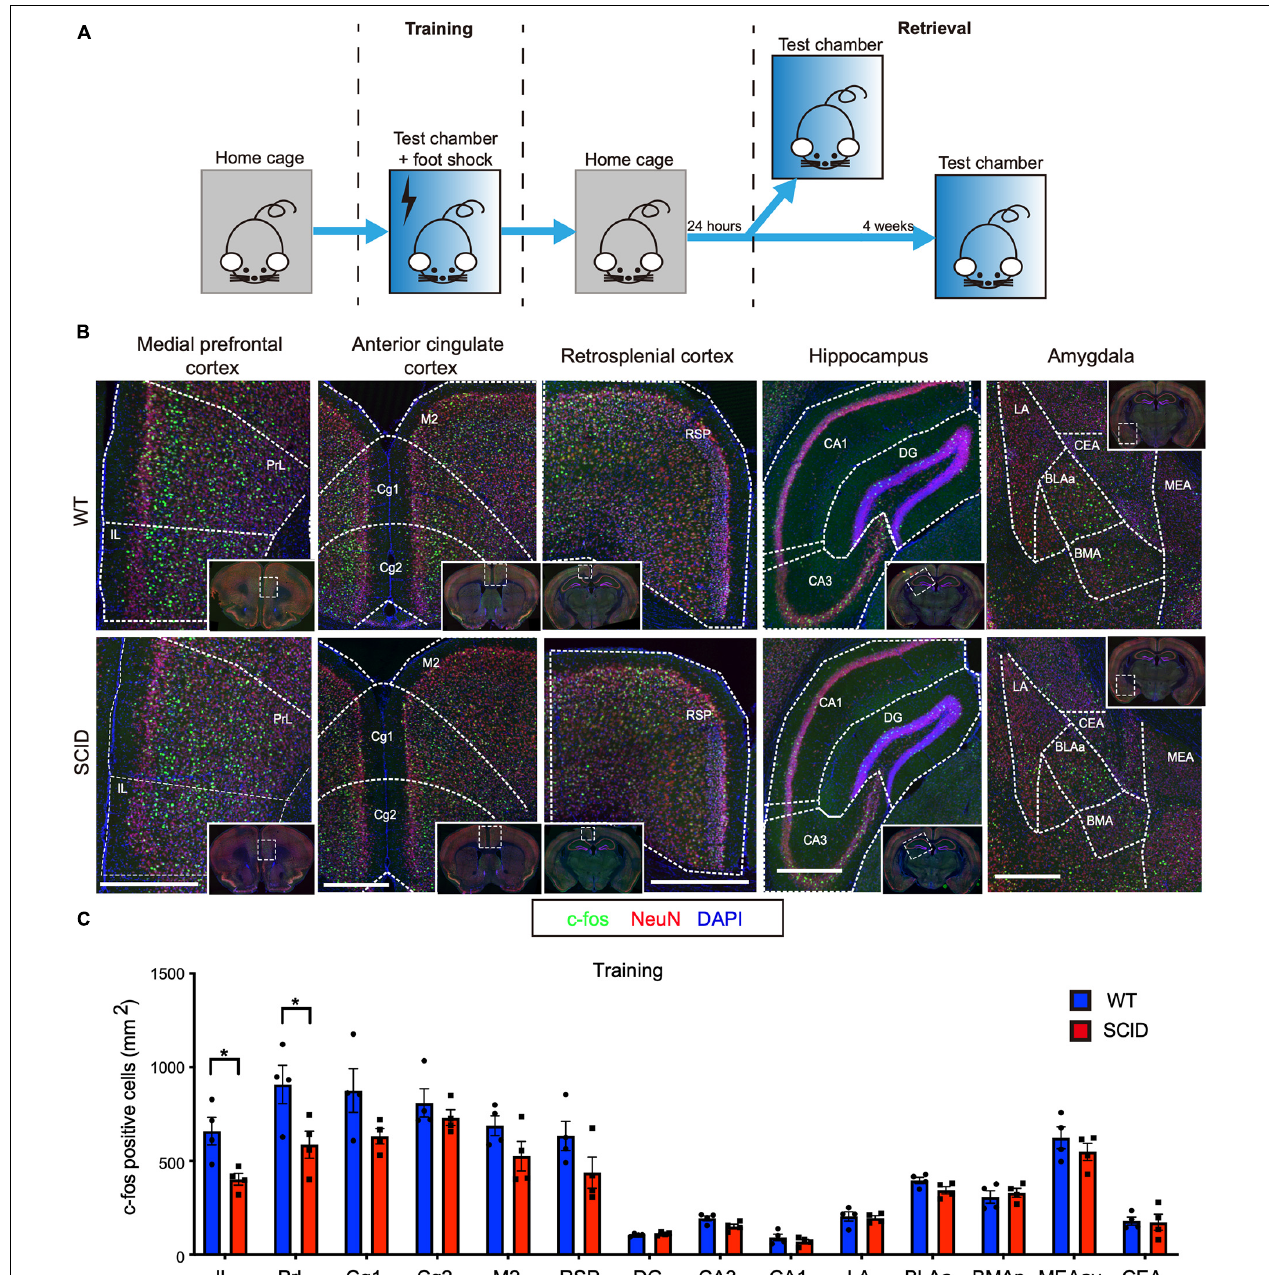
FIGURE 1 | Limited differences in c-Fos expression between SCID and WT mice brain after contextual fear conditioning training. (A) General scheme of contextual fear conditioning training and retrieval. (B) Representative immunofluorescence images of the brain sections from WT (top) and SCID (bottom) mice 90 min after CFC training. c-Fos is in green, NeuN in red, and DAPI in blue. Brain regions: medial prefrontal cortex, anterior cingulate cortex, retrosplenial cortex, hippocampus, and amygdala. Scale bar, 500 µ m. Low-power images were presented in the white solid line frames, with white dotted frames that showed the regions zoomed in. White dotted line outlined most of the brain regions for quantification. (C) c-Fos–positive cell density in different brain regions of WT and SCID mice ( n = 4, data represent mean ± SEM, * p < 0.05).